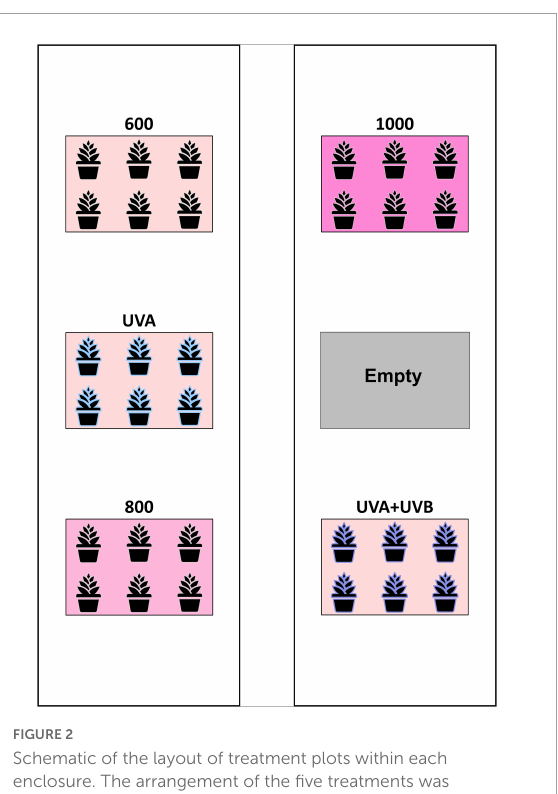
FIGURE2 Schematic of the layout of treatment plots within each enclosure. The arrangement of the five treatments was randomized within the six plot locations in each enclosure (i.e., block) with the sixth plot in each block remaining empty. using a handheld light sensor (LI-180; LI-COR Biosciences, Lincoln, NE, USA) that was spectrum-matched to the PPFD readings of the XR-Flame-S spectrometer under the PAR spectrum in Figure 1A . Light fixture hang-heights were adjusted accordingly to ensure the targeted LI levels in each plot were maintained as the plants